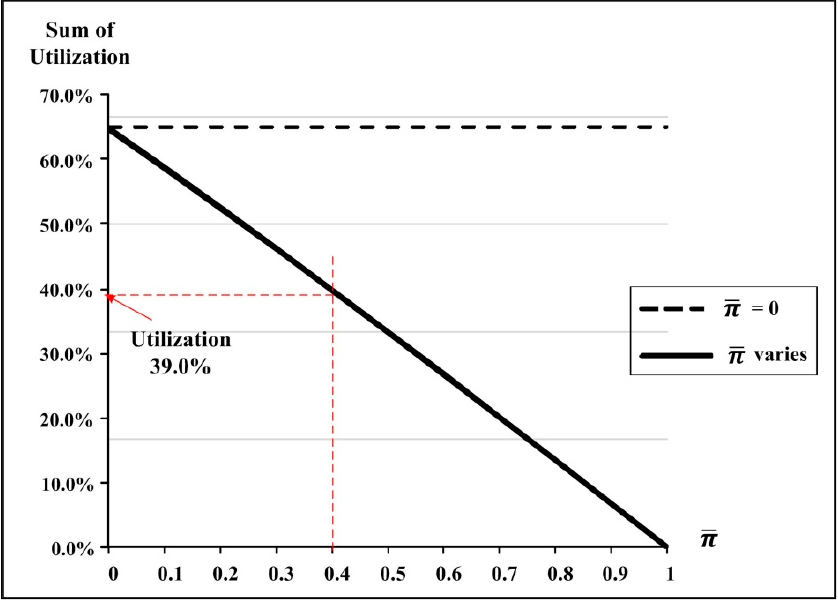
Figure 10. Impact of di ff erences in π on overall machine utilization.